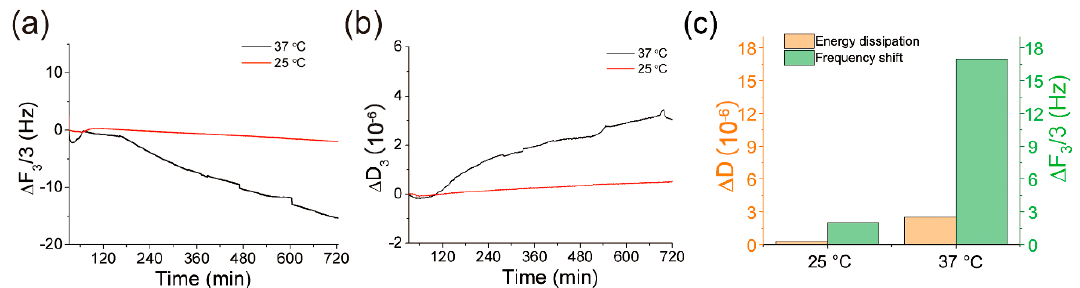
Figure 3. QCM was utilized to monitor the self-assembly of 11-Mercaptoundecanoic acid (MUA) on the gold surface of QCM chips at 25 °C and 37 °C. ( a ) the frequency; ( b ) energy dissipation; ( c ) the summary of QCM signals.